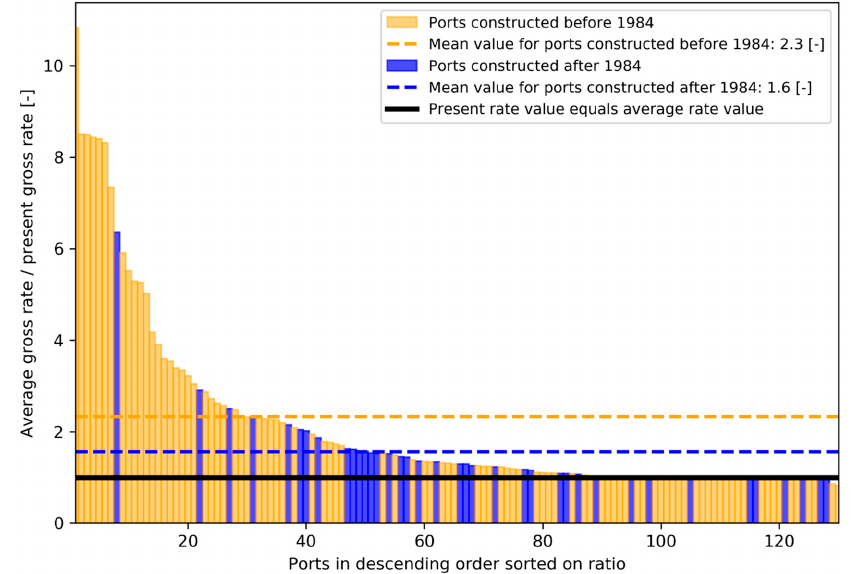
Figure 11. The ratio of the average and present gross areal change rates for all 130 ports in descending order. Orange and blue colours indicate the ratios for the ports constructed before and after 1984, respectively. The mean ratios are represented by the dashed lines.